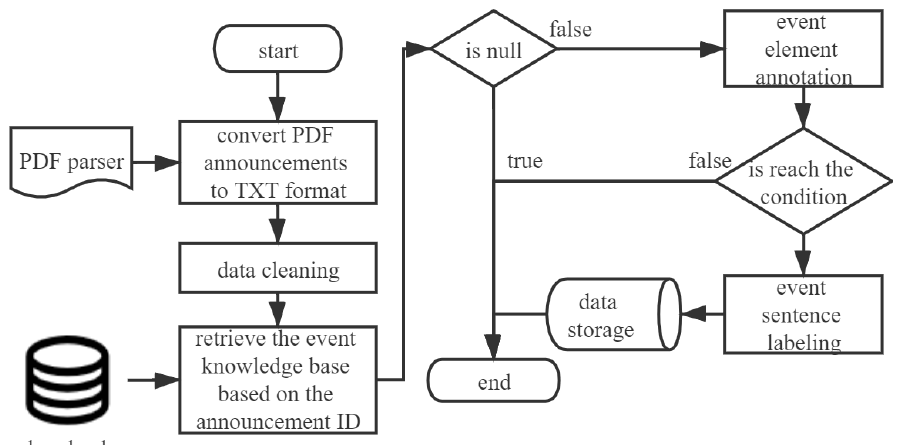
Figure 5. The process of distant supervision event